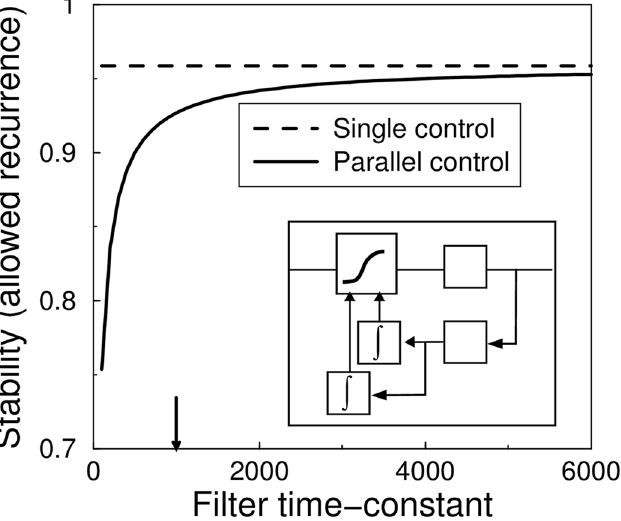
Fig 6. Parallel controllers do not lead to increased stability. The maximal recurrence is plotted against the time-constant of the second feedback loop. The τ 3 time-constant of the system with single feedback is indicated by the arrow. The system with the extra feedback loop (solid curve) is always less stable than the system with a single feedback loop (dashed line), even if the additional feedback is much slower than the original one. The control loop is shown in the